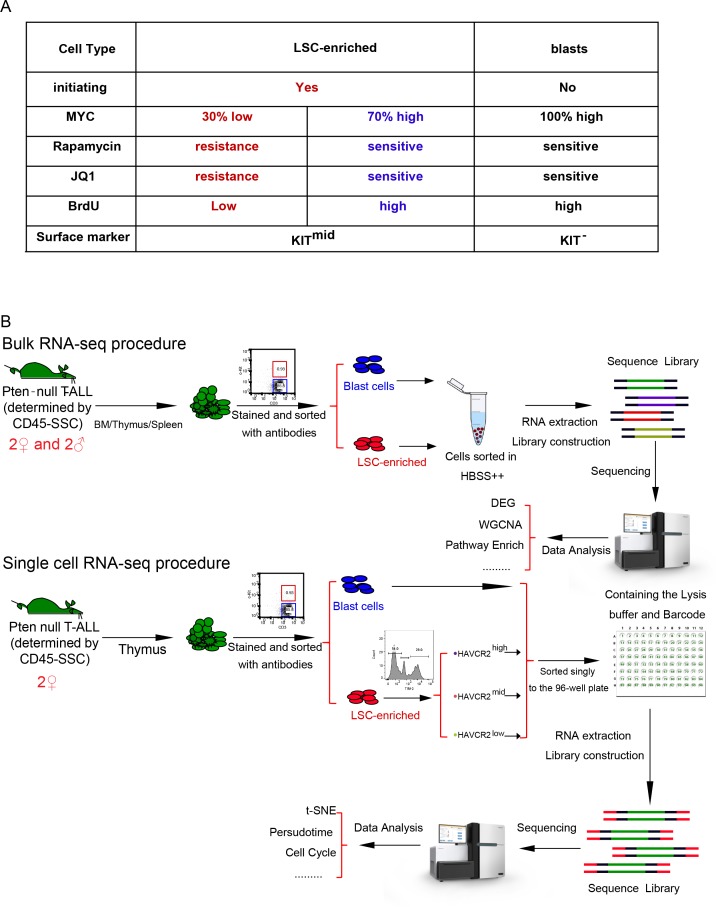
A schematic illustration of procedures used for Bulk and single cell RNAseq analysis.(A) Heterogenous properties of LSC-enriched and leukemic blast subpopulations. (B) Schematic illustrations of the procedures used for the isolation of LSC-enriched and leukemic blast subpopulations and the bulk (upper panel) and single-cell (lower panel) RNA-seq analyses.